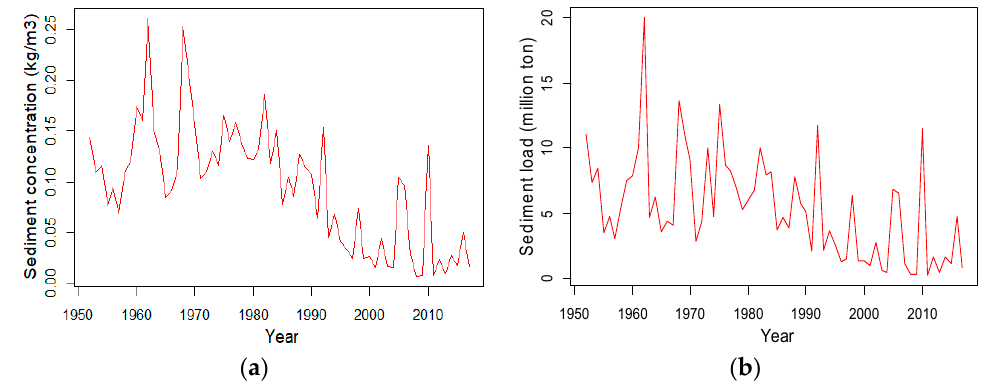
Figure 5. ( a ) Annual average suspended sediment concentration and ( b ) annual suspended sediment load observed at Zhuqi during 1952–2017.